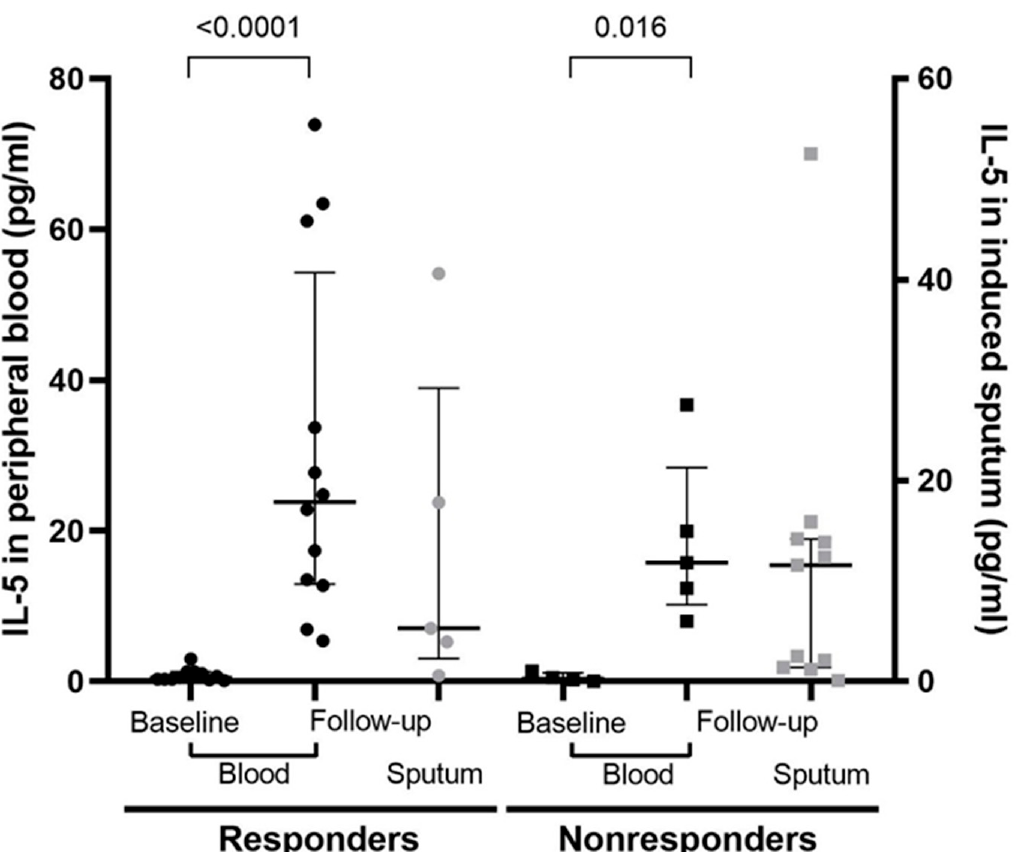
Figure 2. IL-5 concentrations in blood and sputum in both groups at baseline and follow-up.